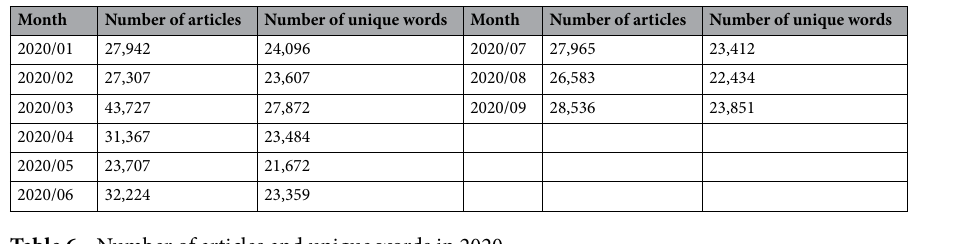
Table 6. Number of articles and unique words in